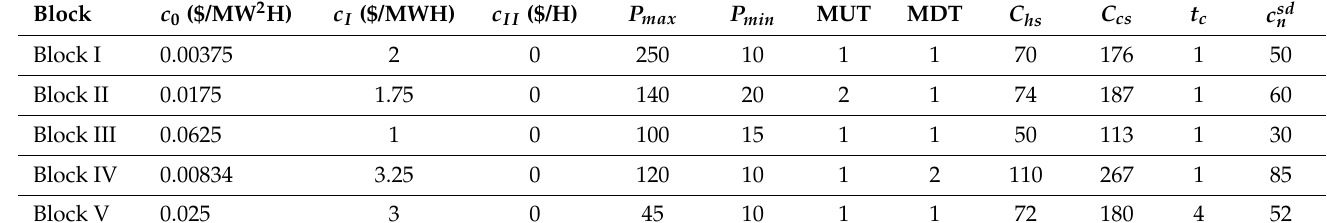
Table 3. Power Blocks data of Gen-Co-G for IEEE-14 Bus System [30].